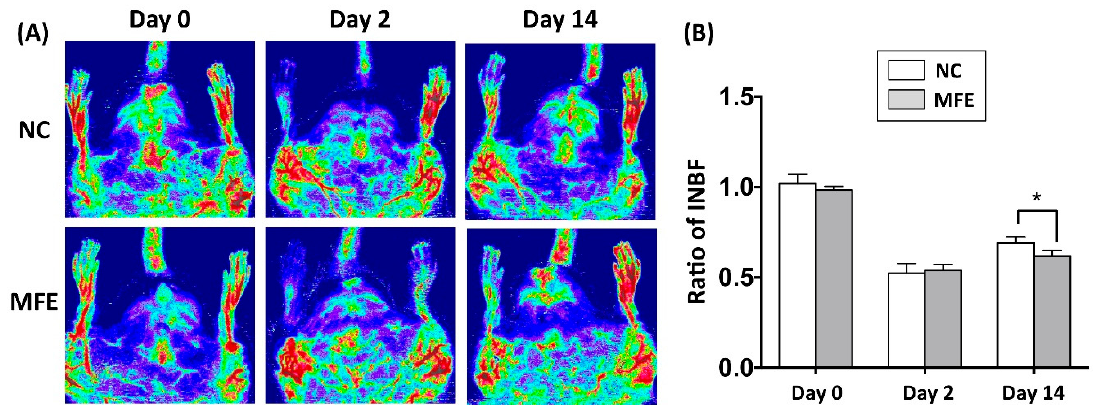
Figure 3. Maternal fructose exposure reduced blood flow recovery after induction of critical limb ischemia. ( A ) Laser Doppler scanning to determine the blood flow recovery after induction of CLI. ( B ) Quantitation and calculation of blood flow. The parameter ratio of ischemia to normal blood flow (INBF) was used to evaluate the blood flow recovery initiated by neovascularization after CLI. On day 2 after CLI and day 0 prior to CLI, the ratio of INBF showed no difference between NC and MFE groups. However, by day 14, the blood flow recovery in the NC group was significantly higher than the MFE group. NC, normal control; MFE, maternal fructose exposure; CLI, critical limb ischemia. Error bars represent the standard deviation (SD). * Indicates statistical significance between NC and MFE group. n = 8 for each group.